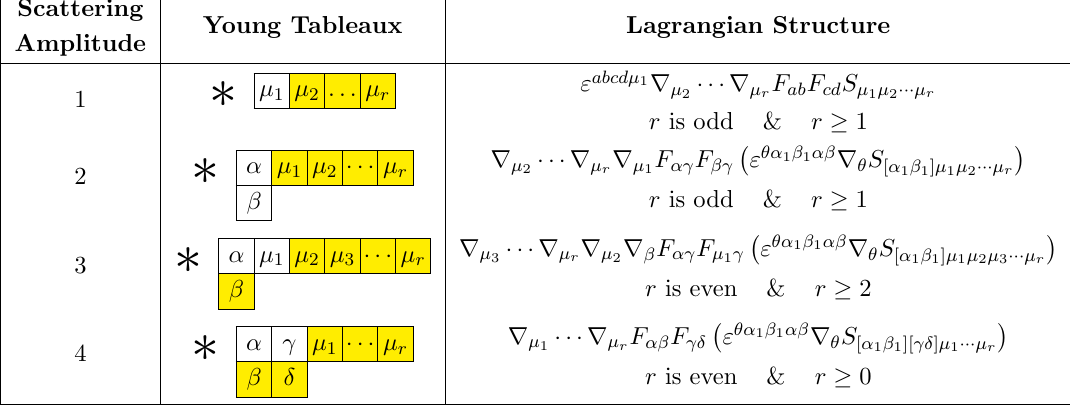
Table 3. Photons , D = 5. Here | and also for the analogous table for gravitons in D = 5 later (cid:3) in this paper | the symbol has one of two meanings. Whenever the SO(4) representation is symmetric traceless | as in Row 1 in this table | this symbol indicates that fusion of the unshaded part of the Young Tableaux occurs with the SO(3) Hodge star of the representation on the r.h.s. of (3.2) (or analogous representation in the case of gravitons). In rows 2 and 3 of this table the same symbol indicates that the original SO(4) Tableaux is Hodge stared before we shade in boxes and then fuse with photon